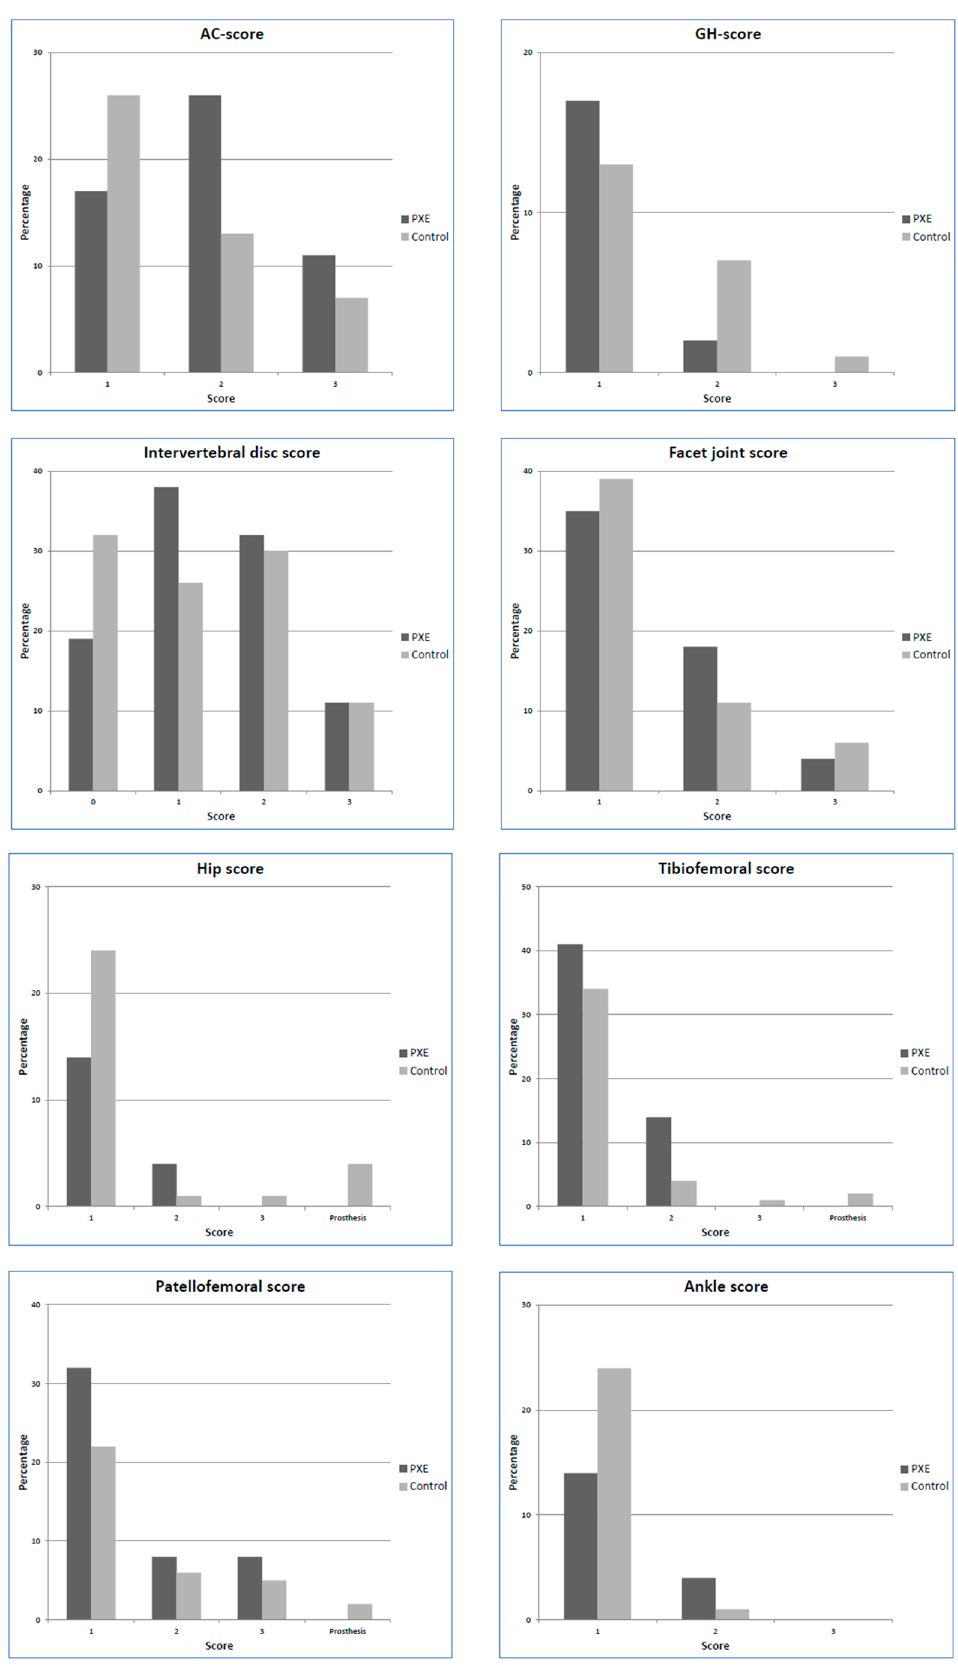
Figure 2. Frequencies of osteoarthritis scores for each joint for the pseudoxanthoma elasticum (PXE) and controls. AC: acromioclavicular; GH: